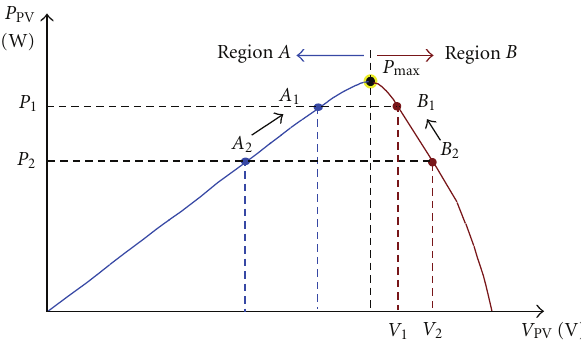
Figure 7: PV output power curve with respect to the PV output voltage.